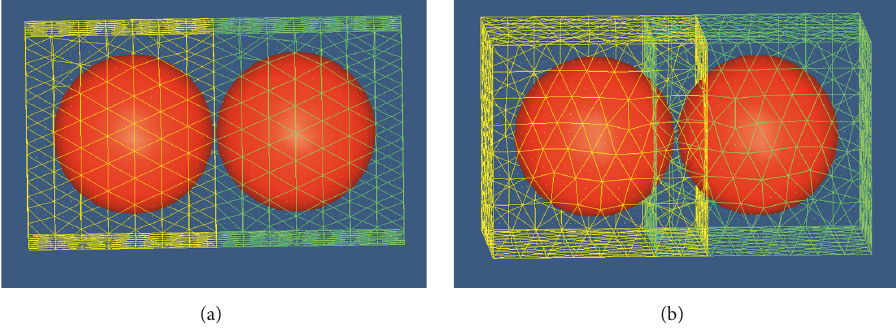
Figure 8: Two PEC spheres enclosed by two ES, (a) T-EPA scheme, and (b) GSST-EPA scheme.